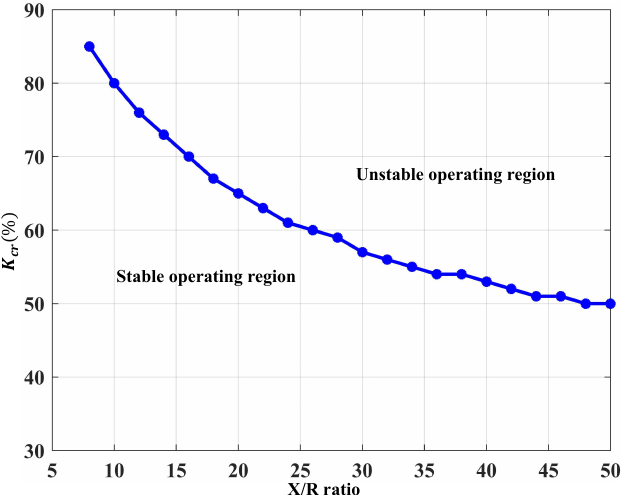
Figure 6. Stability boundary with respect to X / R ratio of